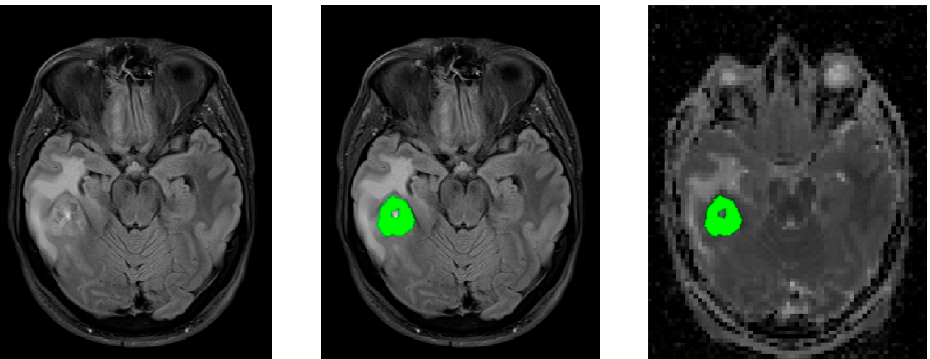
Figure 2. FLAIR and DW Images of histopathologically confirmed IDH-wt Glioblastoma-patient: unmodified FLAIR ( left ); FLAIR with drawn-in tumor region ( green ); excluding central necrosis and surrounding edema ( middle ); ADC map from DWI, fitted to the matrix of the FLAIR images, with transferred tumor region ( right